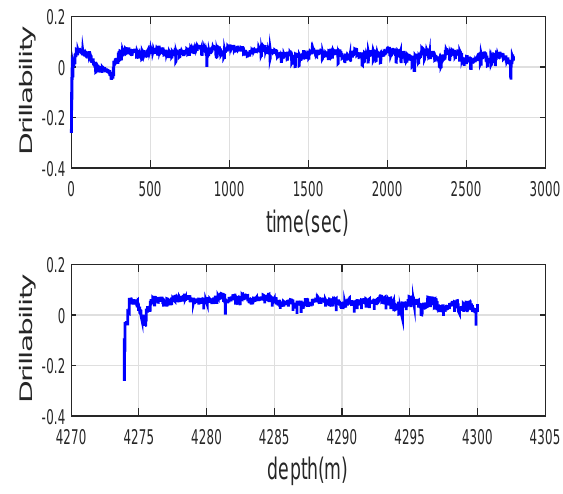
Figure 4: Drillability calculated in the case study